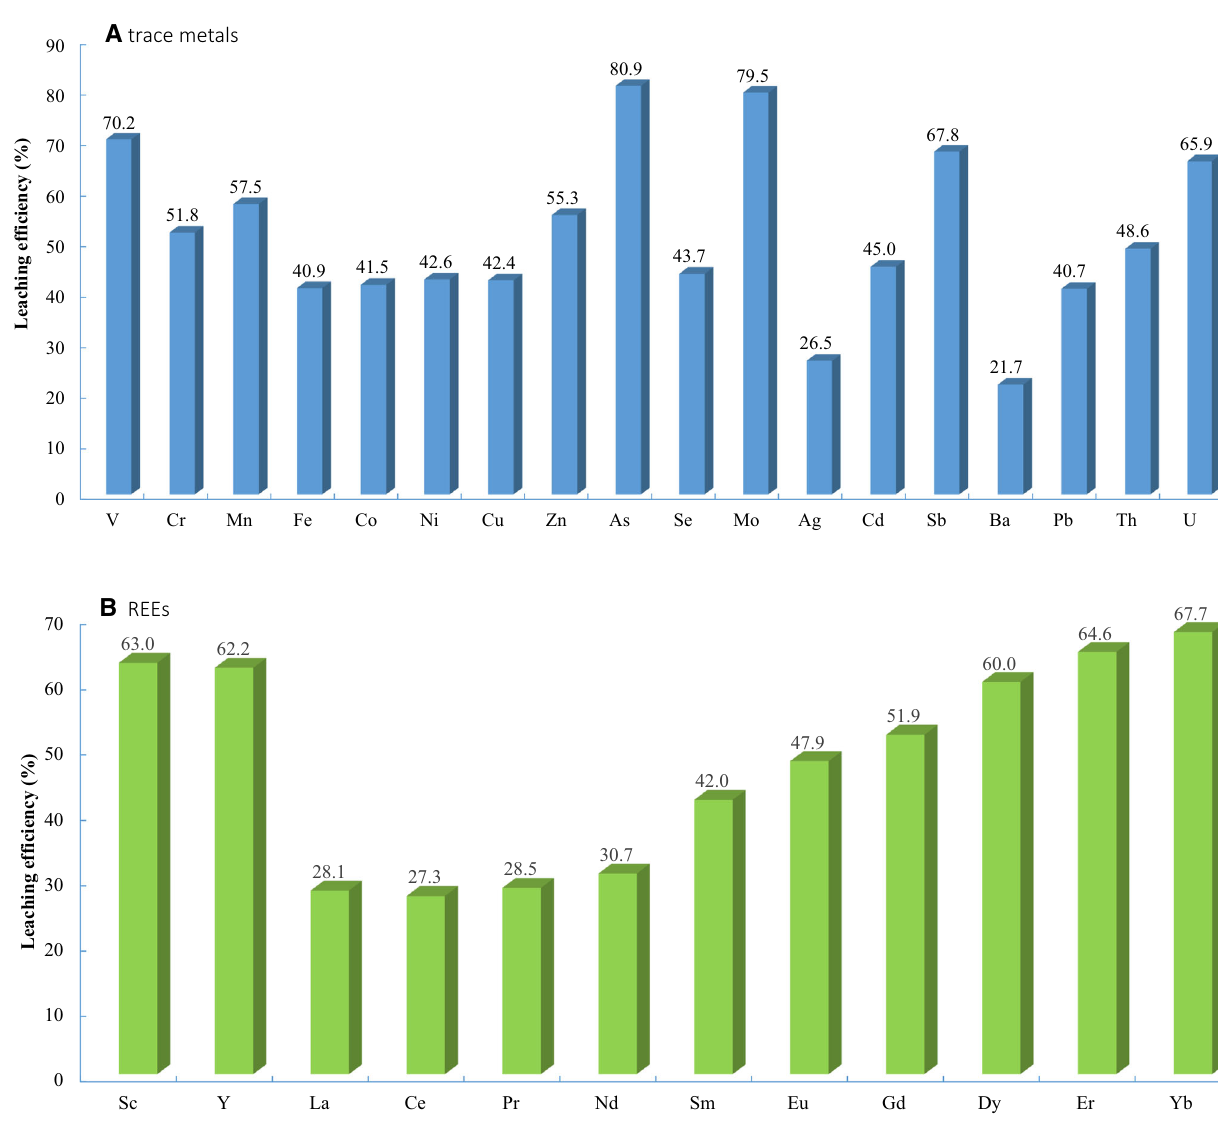
Fig. 2 Mineral loss resulting from using supernatant for leaching fresh fly ash